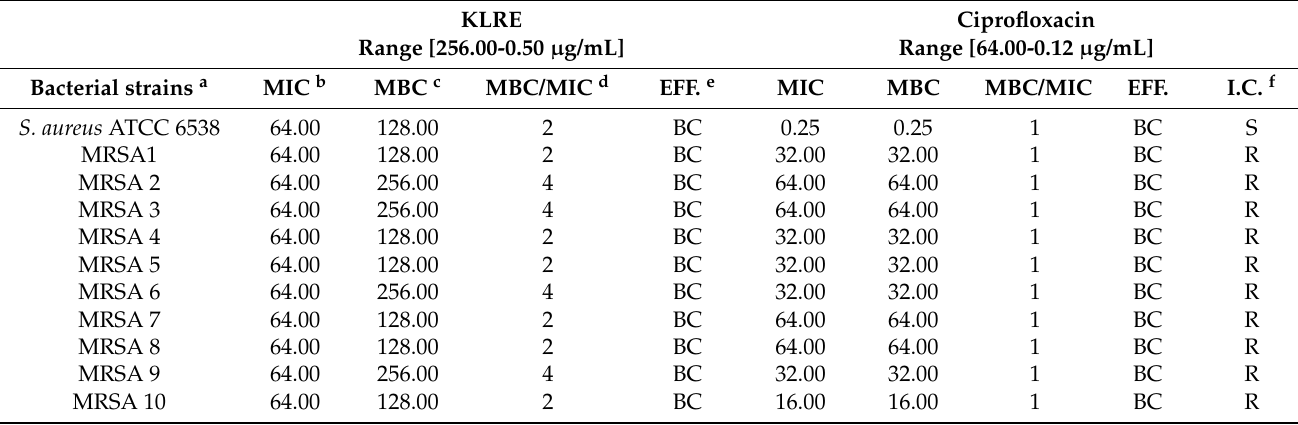
Table 1. Minimal Inhibitory Concentration (MIC), Minimal Bactericidal Concentration (MBC) and MBC/MIC ratio of Krameria lappacea root extract (KLRE) and ciprofloxacin against Staphylococcus aureus strains.